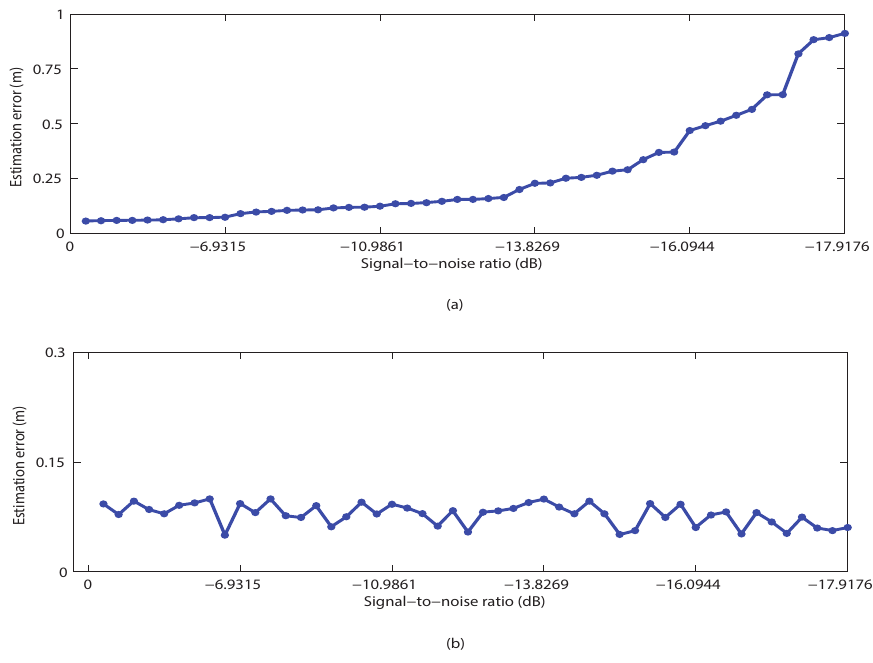
Figure 9. Noise elimination scheme performance. ( a ) Estimation errors of LED without noise elimination; ( b ) Estimation errors of LED with noise elimination.